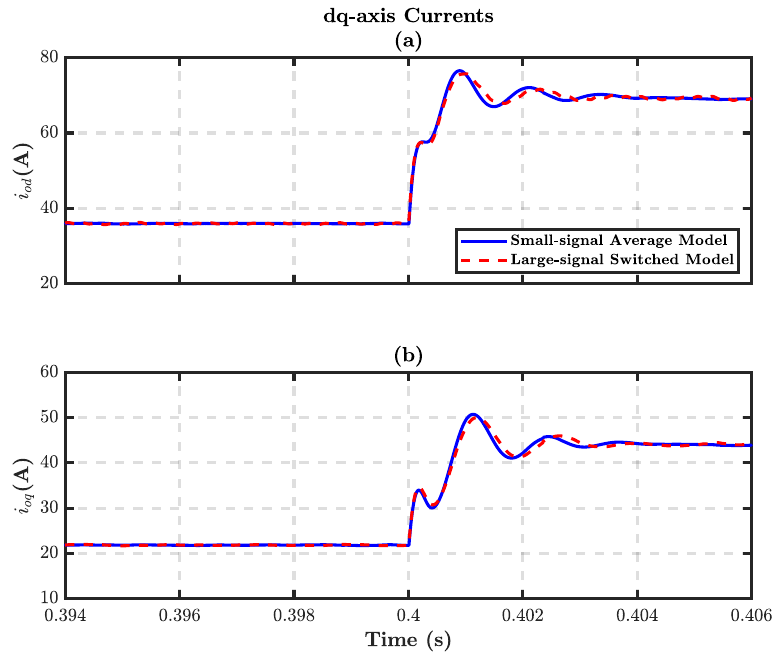
Figure 5. The validation of the small-signal model of the islanded MG with one inverter: ( a ) d -axis current; ( b ) q -axis